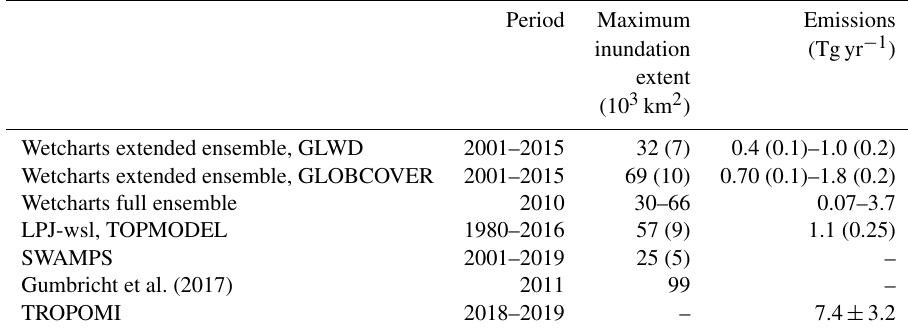
Table 2. Annual emission and maximum inundation extent estimates for SSWR. The values in parentheses show 1SD spread over the given periods. The dashed values give the range of Wetcharts ensemble